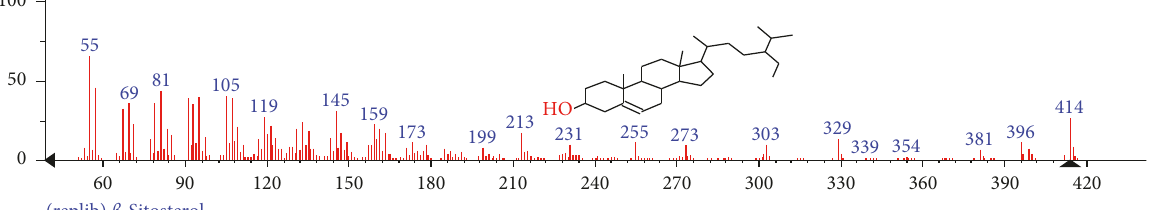
-Sitosterol60 90 (replib) β Figure 62: Mass spectrum of compound β -sitosterol of whole plant hexane fraction of Achillea wilhelmsii (WHFAW).